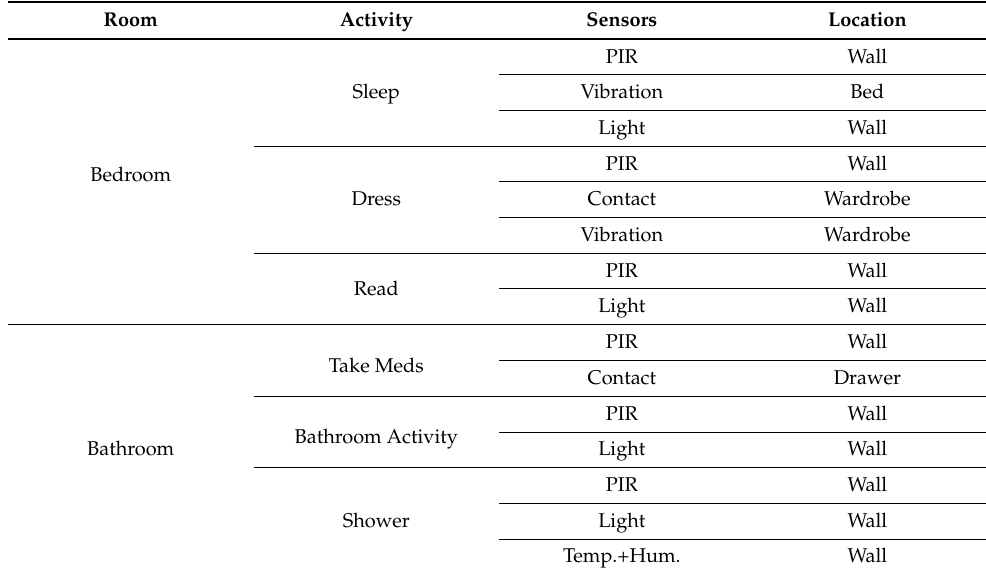
Table 3. Study of sensors needed to detect the proposed